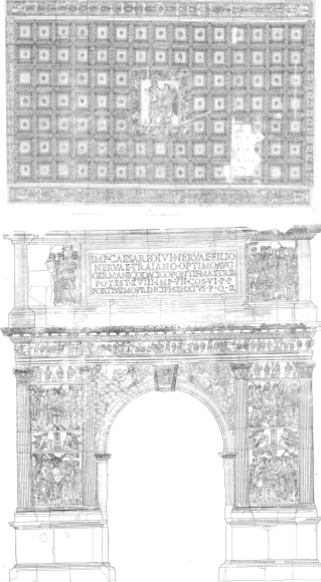
Figure 1. East Façade and The Fornice (bottom view) – Architectural Survey. Soprintendenza Archeologica delle